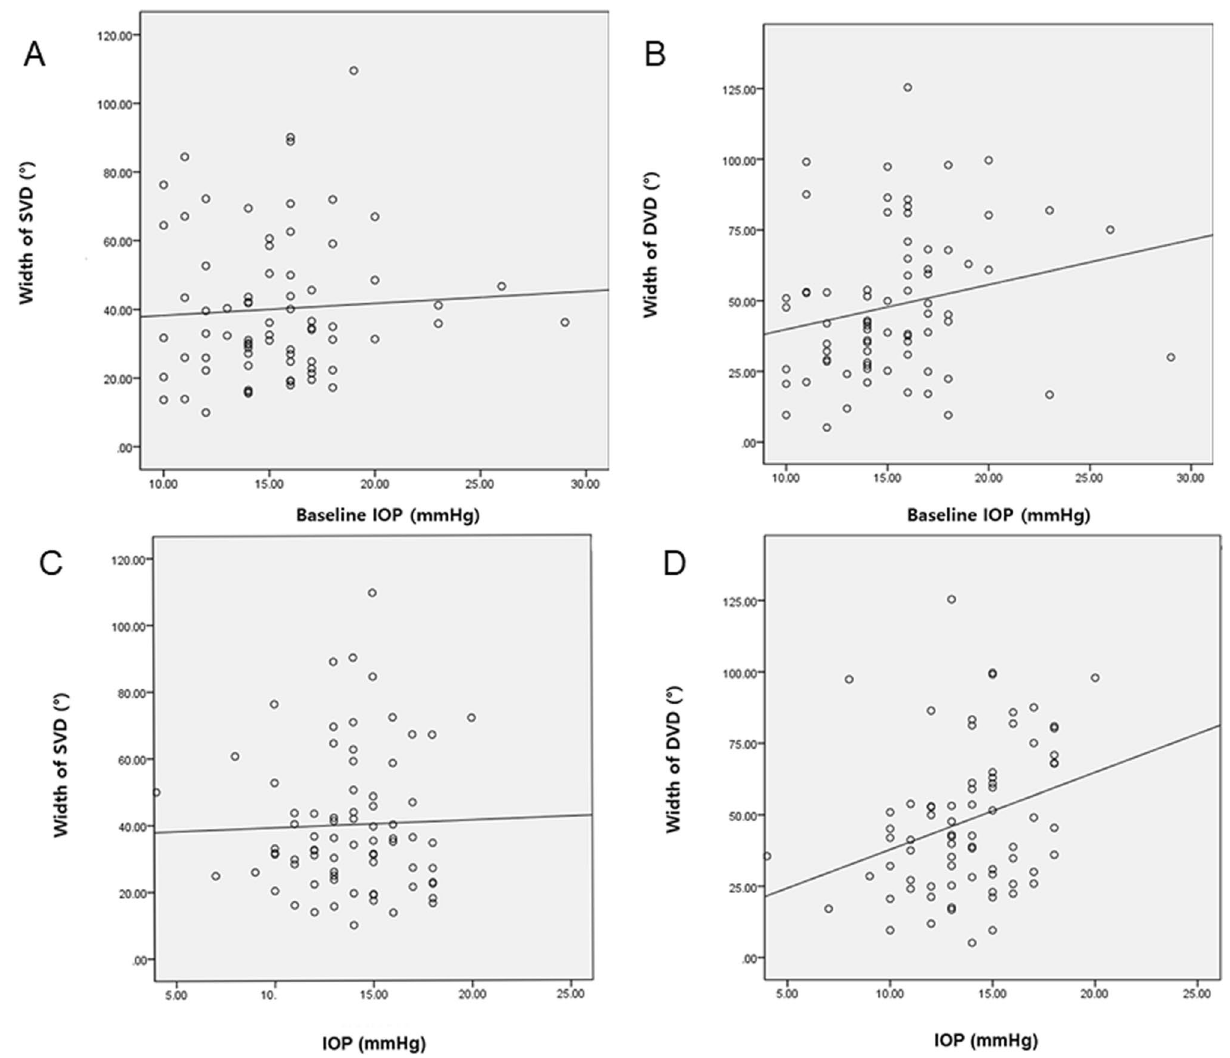
Figure 2. Relationship between the Width of Vessel Density Defect in Superficial or Deep layers and Baseline Intraocular Pressure, measured Intraocular Pressure at OCTA examination. The correlation between the width of superficial vessel defect (SVD) and baseline intraocular pressure (IOP) ( A ) and the IOP measured at OCTA examination ( C ) did not show statistical significance. Nevertheless, the width of deep vessel defect (DVD) presented markedly significant relationships with the baseline and the measured intraocular pressures ( B , D ). Pearson correlation analysis was